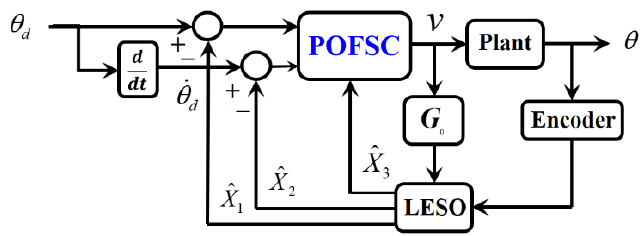
Figure 12. A control block diagram of the proposed POFSC.